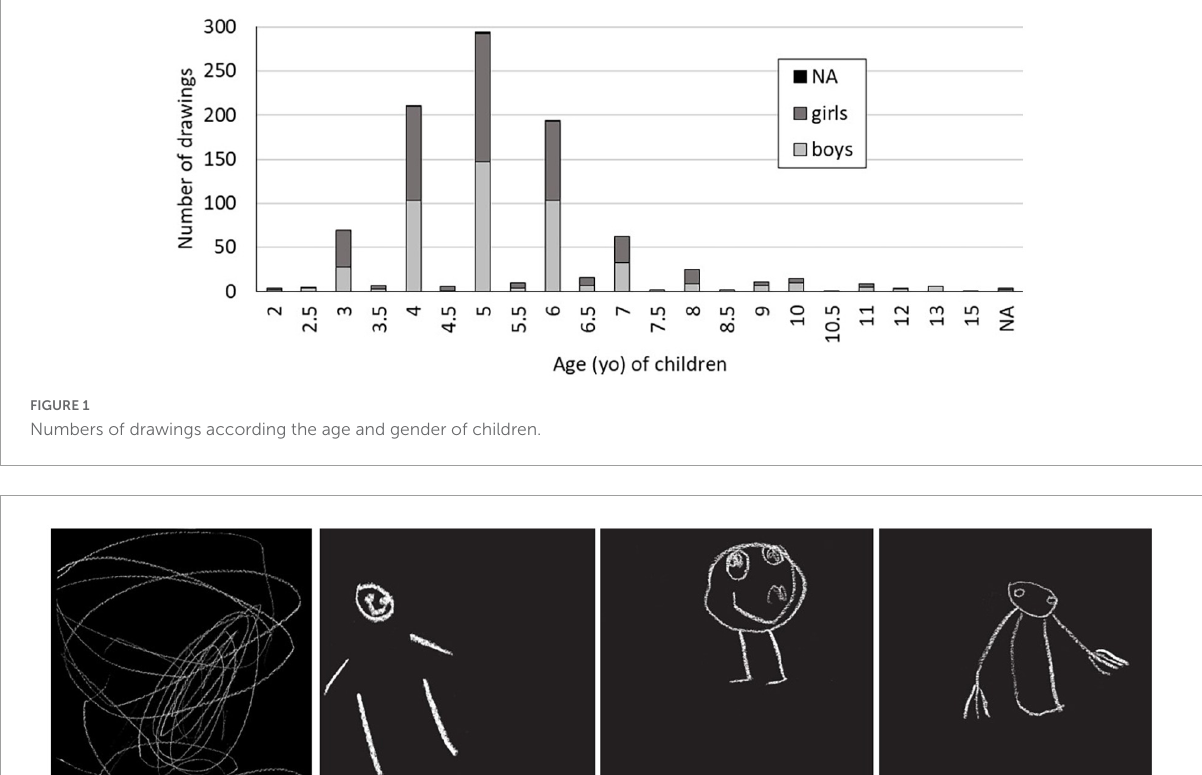
human faces and hands, (4) elements from Nature and (5) man-made objects, and (6) the personification of 4 and 5; (7) representations of animals, (8) additional human figures, (9) symbols, (10) letters and numbers, and finally the size of (11) head of human figure (ratio head/body), (12) human figures (MCP), and (13) entire drawings (MCP) ( Table 1